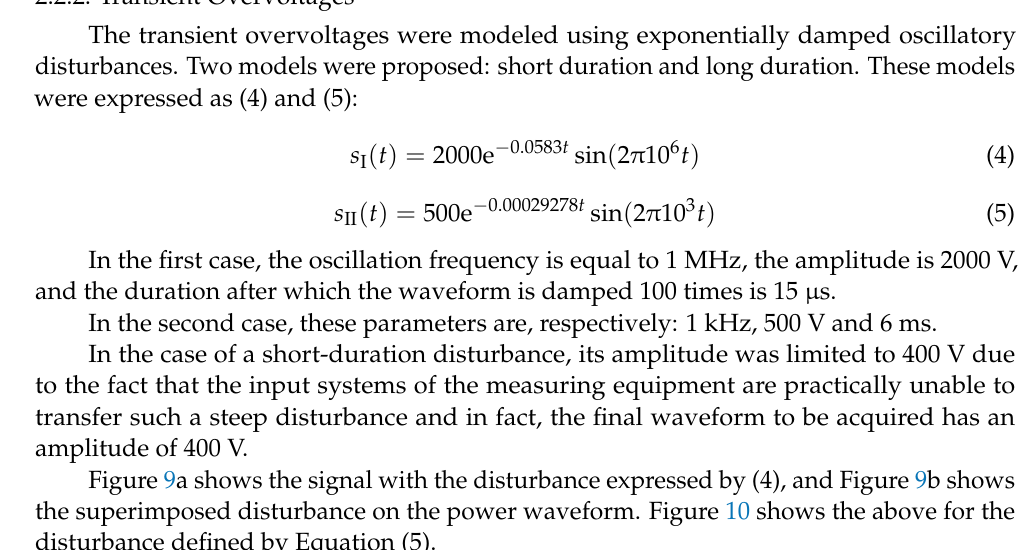
Figure 8. Models of ( a ) harmonic and ( b ) interharmonic disturbances.